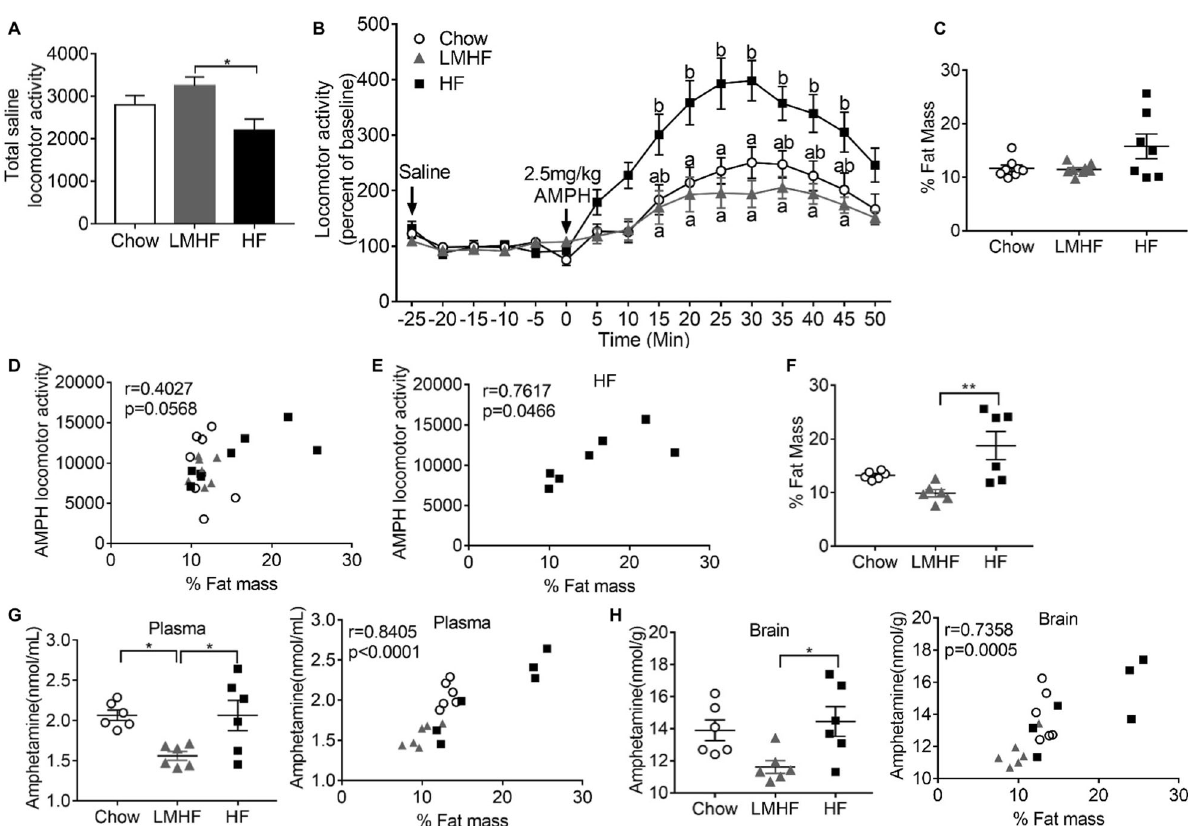
Fig. 4 Effect of HF diet and adiposity on AMPH-induced locomotor activity and AMPH levels in plasma and brain. A The baseline locomotor activity was lower in WT mice fed the HF diet (HF), compared to those that were given limited access to HF diet (LMHF). n = 8/ group. B The normalized locomotor response to AMPH is higher in HF mice compared to Chow or LMHF mice. Two-way ANOVA with RM revealed a signi fi cant effect of time ( p < 0.0001), a signi fi cant effect of group ( p = 0.0015), as well as a signi fi cant interaction between the time X group ( p = 0.0001). Different letters indicate statistically signi fi cant differences ( p < 0.05) at individual time points based on Bonferroni post- hoc testing. C Adiposity (% Fat Mass) values for each mouse used for locomotor testing. D Correlation between % fat mass and AMPH locomotor activity for mice in all three groups falls just outside the signi fi cance threshold ( p = 0.0568). E Limiting correlation to HF mice yields a p value (0.0466) just within the threshold for signi fi cance. F Adiposity (% Fat Mass) values for each mouse used for determination of amphetamine levels are shown. Adiposity of the HF group is signi fi cantly greater than that of the LMHF group. n = 6/group. G Panel at left shows that plasma amphetamine levels are higher in Chow or HF groups compared to LMHF group. The right panel shows a strong correlation between % fat mass and plasma amphetamine levels ( p < 0.0001). H Panel at left shows that brain amphetamine levels in the HF group are higher than those in the LMHF group. The panel at right shows a strong correlation between % fat mass and brain amphetamine levels ( p =